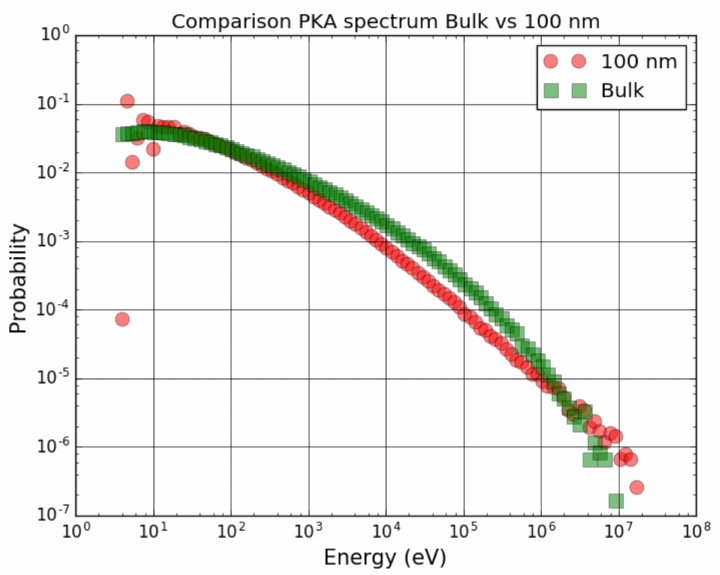
Figure 8. PKA spectrum comparing thin films (100 nm) and bulk by means of MARLOWE code.